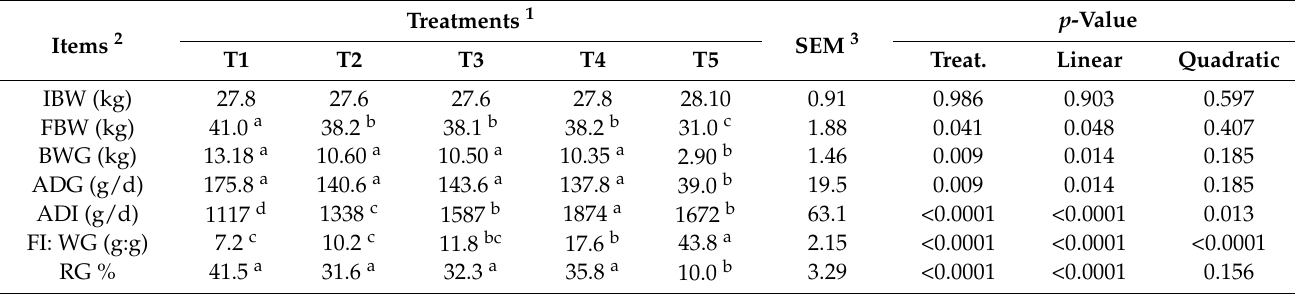
Table 2. Growth performance for growing lambs fed on dietary treatments with different levels of sprouted barley from 1 to 75 days.